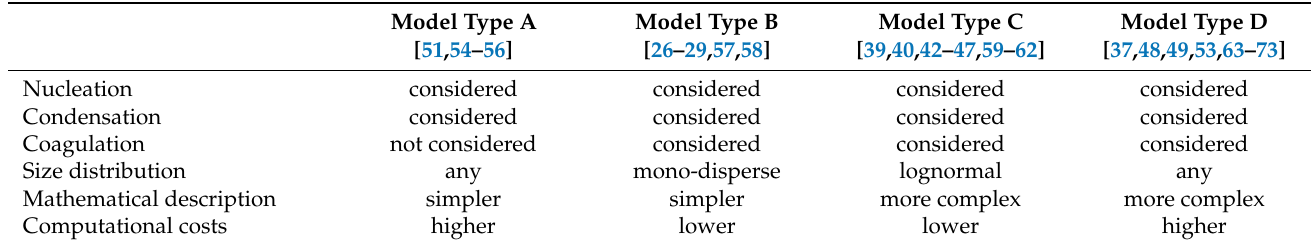
Table 1. Computational growth models based on aerosol